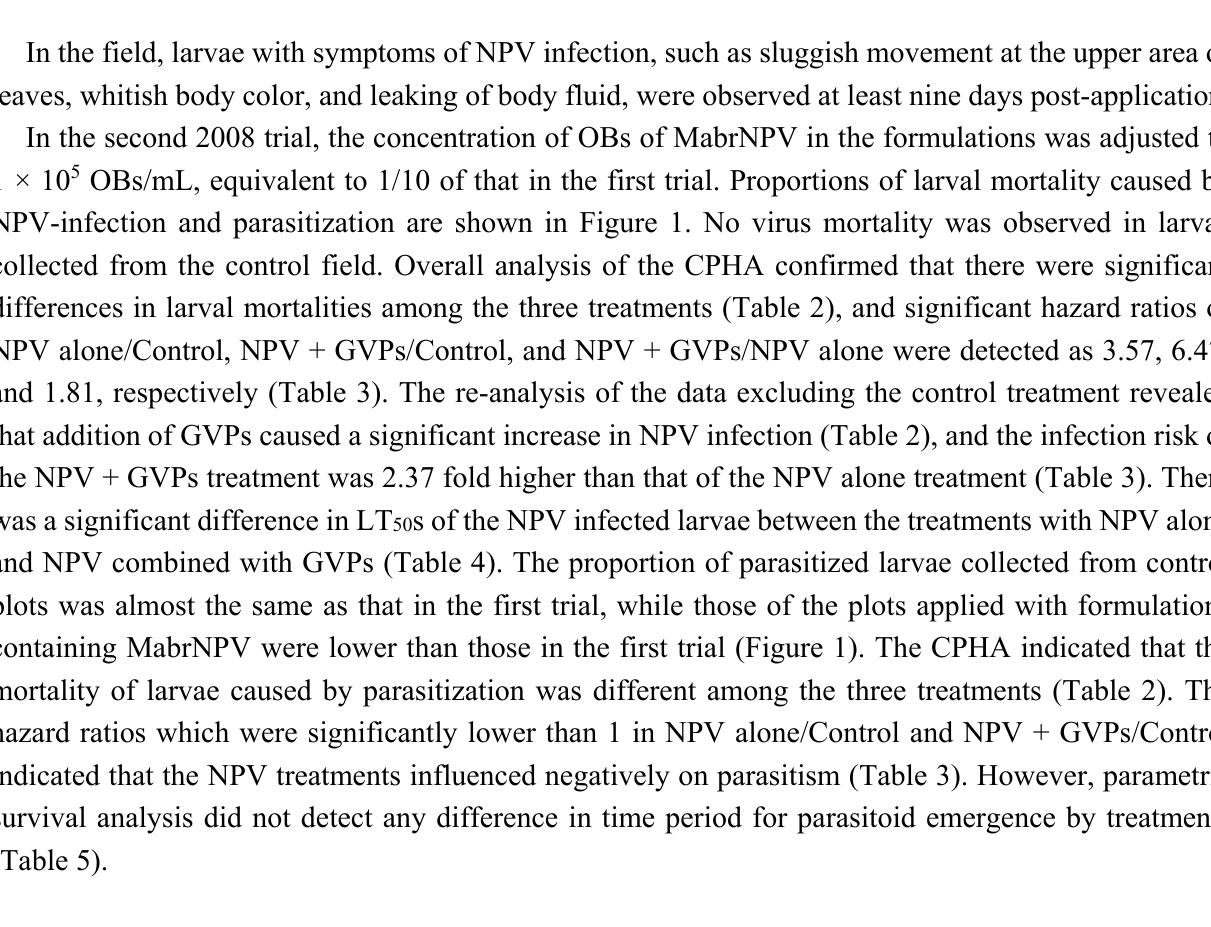
Figure 1. Proportion of mortality caused by NPV infection and parasitoids in the 2008 and 2009 field trials. The number above each column represents the number of larvae for each treatment plot by